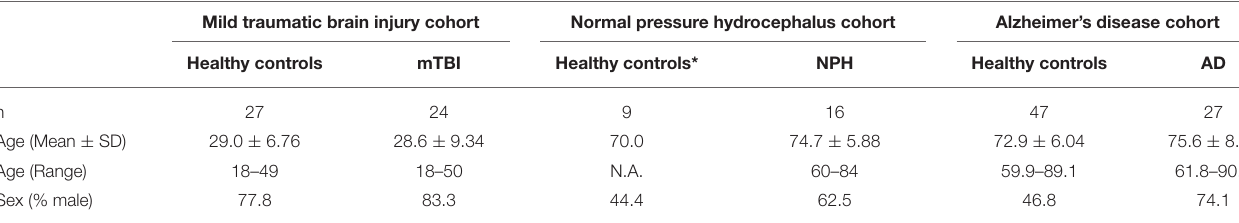
TABLE 1 | Demographics for